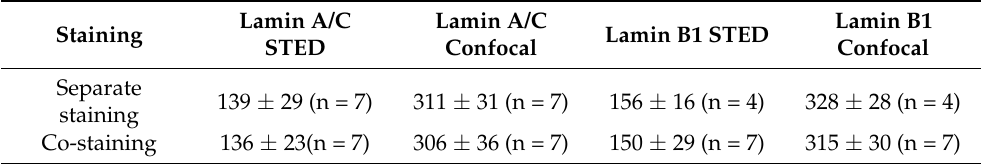
Table 2. Average STED and confocal microscopy FWHM ± SD (nm) as a measure of the lamin layer thickness of lamin A/C and B1 in laminopathy patient dermal fibroblasts with an LMNA c.1130G>T (p.(Arg377Leu)) variant, stained with antibodies against lamin A/C and/or lamin B1. The layer thickness was determined at 1–5 positions in each